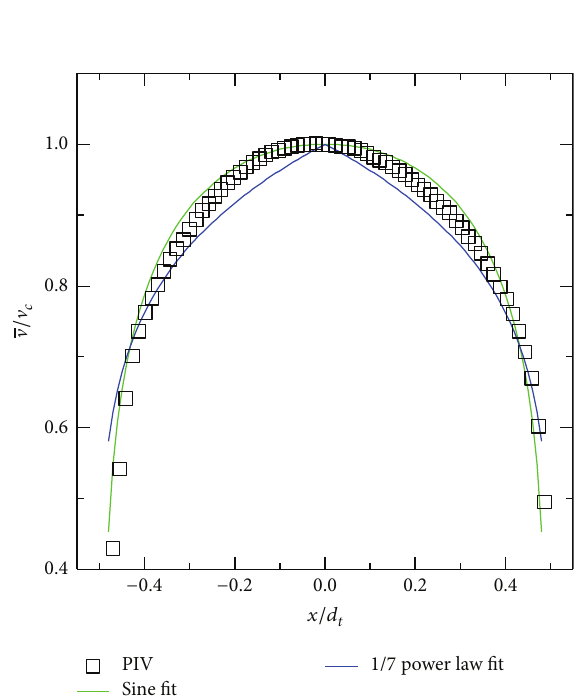
Figure8:PIVdatawithasinefitapproachtogetherwiththeclassical 1/7 power law at 𝑦/𝑑 𝑡 = 0.097 above the injection pipe